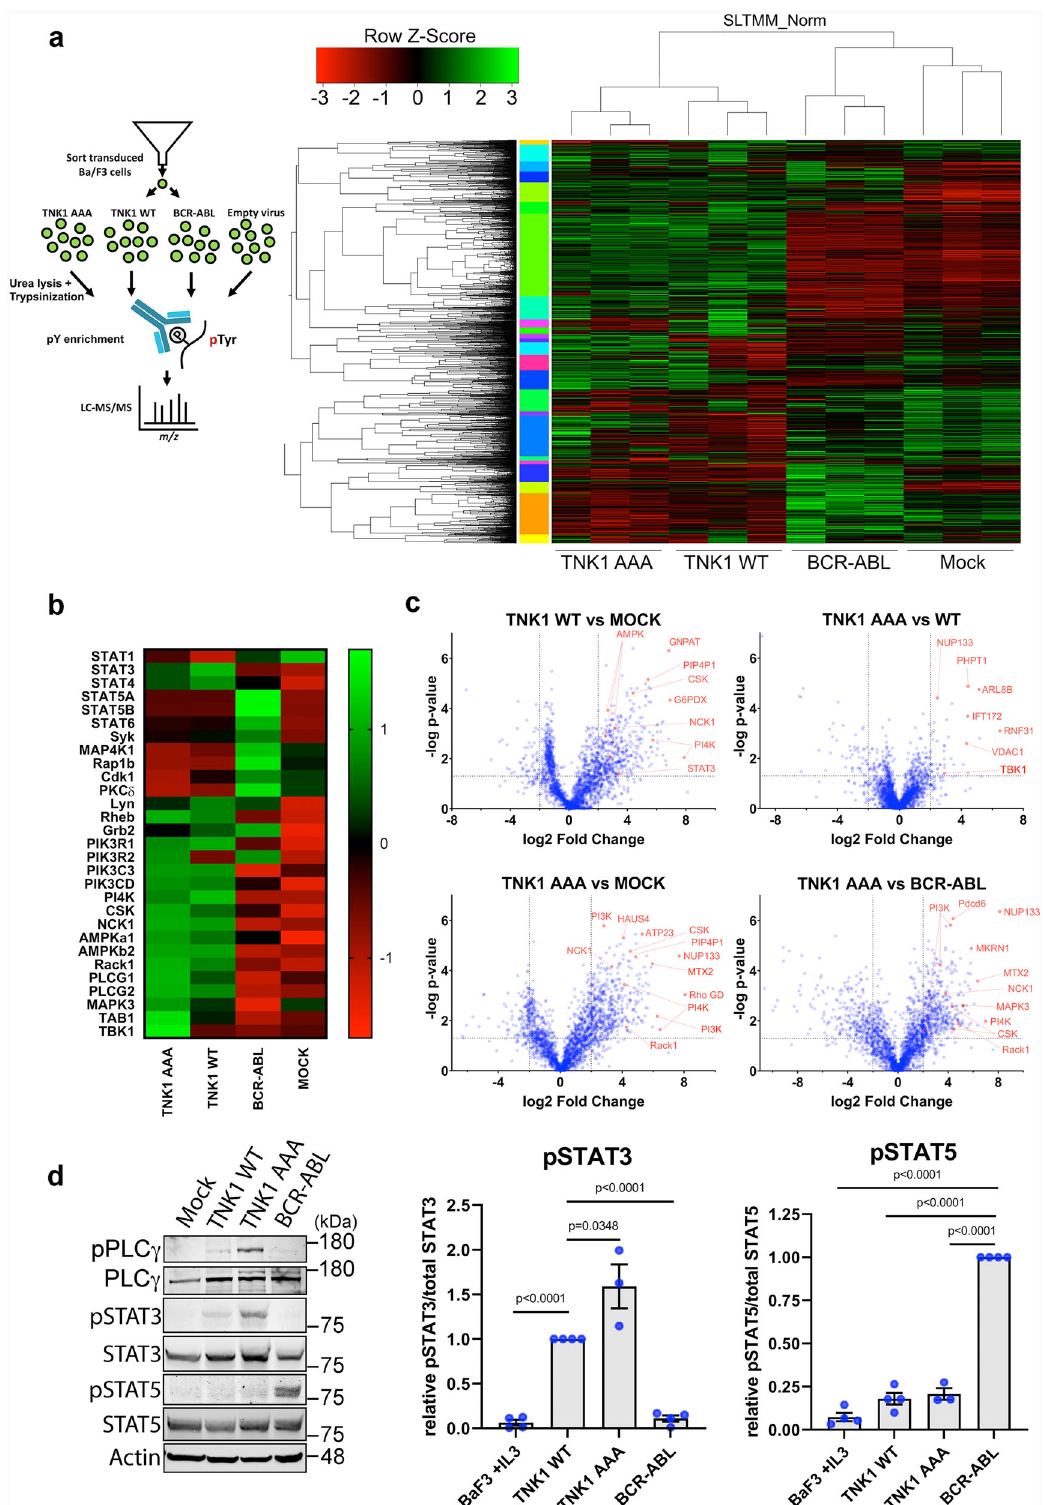
fi ngerprint emerged for TNK1, relative to BCR-ABL, across a number of proteins, including multiple PI3K subunits, PI4K, Pairwise comparisons of the kinases or kinases to mock